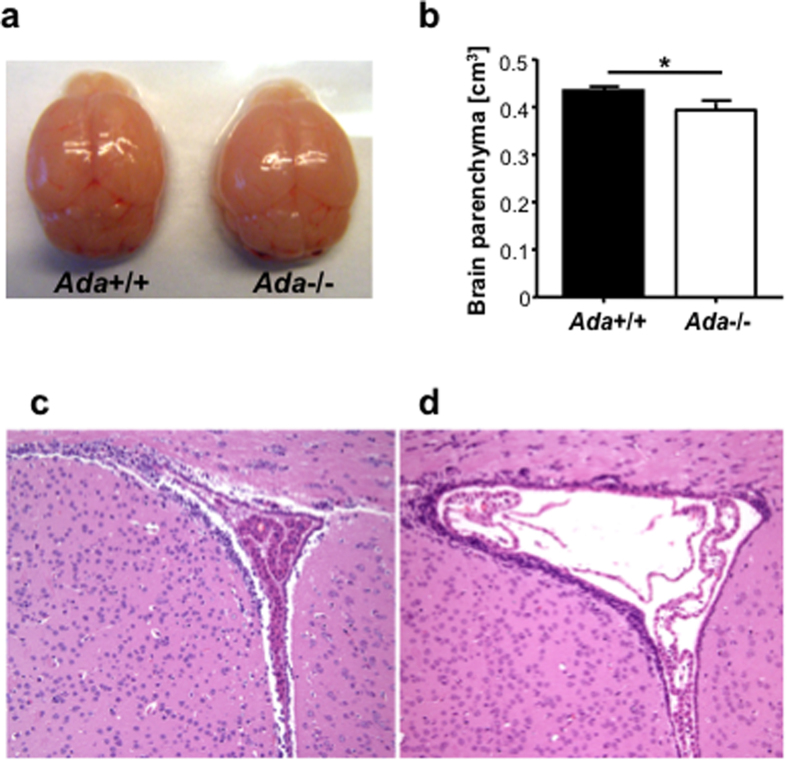
Alterations in the brain morphology of Ada−/− mice.(a) Brain explants from Ada−/− mice are smaller in size as compared to Ada+/+ brains. Upper view of Ada+/+ and Ada−/− brains at PND19. (b) Volume of brain parenchyma assessed by MRI of Ada+/+ (n = 6) and Ada−/− (n = 5) mice at PND20; *p < 0.05. Hematoxylin and Eosin staining of the lateral ventricles of 3 weeks old (c) Ada+/+ and (d) Ada−/−; 10x.